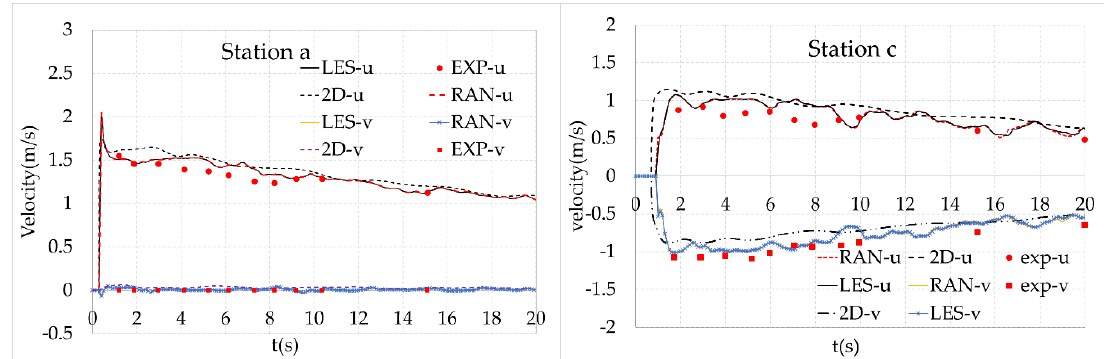
Figure 5. Water hydrographs at gauges a and c.